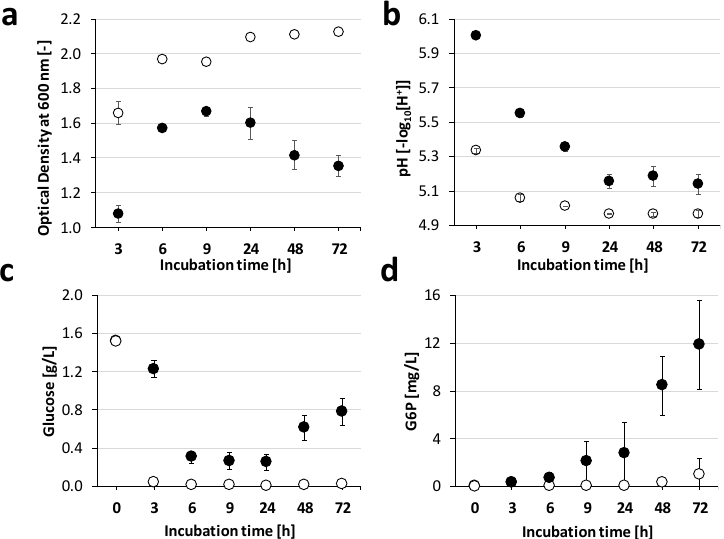
Figure 2. Growth and fermentation in the presence of monensin triggers intracellular sodium efflux in P. bryantii B 1 4. ( ⚪ 0 µM and ⚫ 20 µM). Parameters were obtained from 100 mL cultivations after 9 h growth under monensin concentrations (0, 10, 20 and 50 µM). The average of six biological replicates was displayed for every measurement and condition. Error bars indicate standard deviation if not stated separately. ( a ) Optical density. ( b ) pH, adjusted pH of 6.8 is displayed for the non-inoculated pure medium. ( c ) Intracellular Na + concentration analyzed by ICP-MS and standardized by the protein concentration. The treatment without monensin was set as reference (100%) and error bars indicate standard error mean (SEM). ( d ) Relative D-glucose concentration in supernatant, which is in pure medium below the supplemented 2 g/L due to the Maillard reaction during autoclaving.